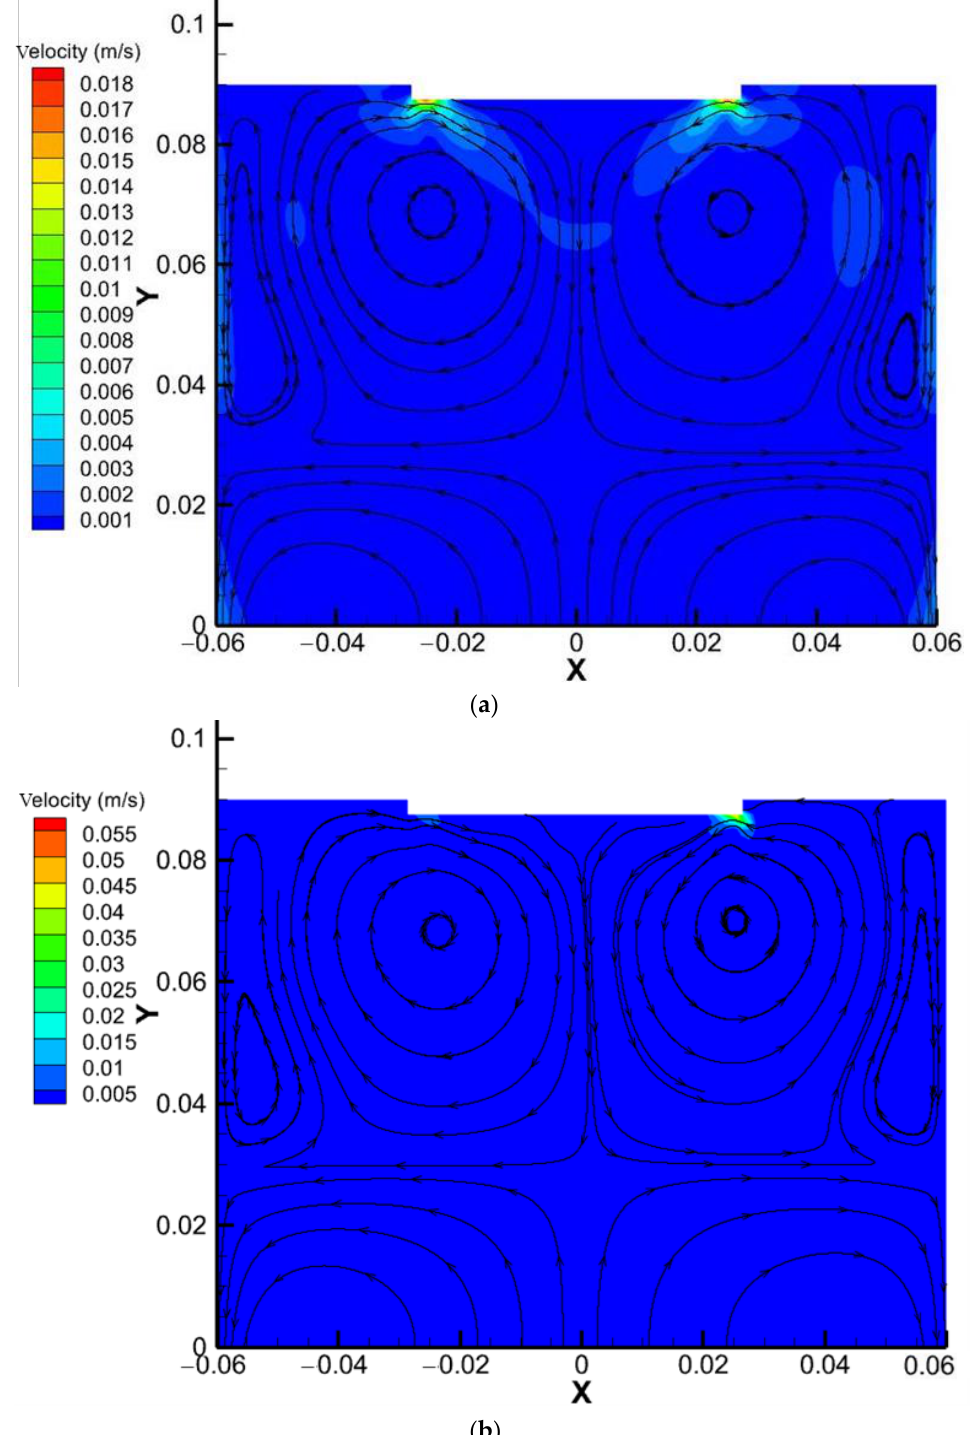
Figure 5. Flow field and streamlines distribution with different electrode vibration frequency ( a ) 0.25 Hz and ( b ) 1 Hz.